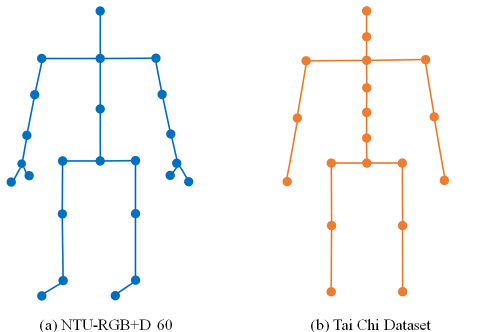
Figure 6. Skeletons of NTU-RGB+D 60 and Tai Chi